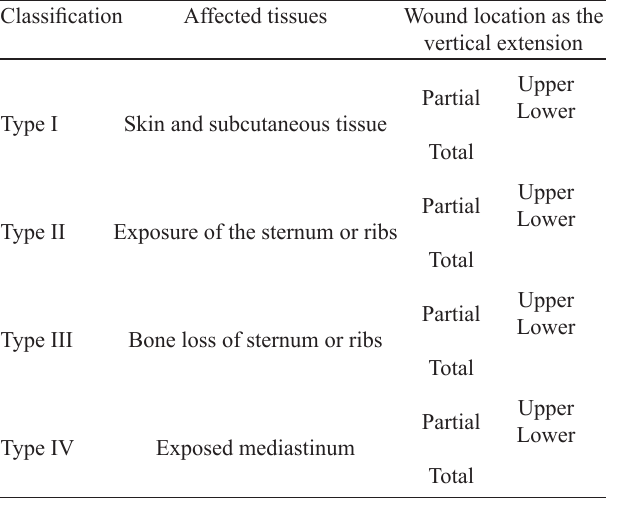
Table 5. Classification proposed by the authors based on anatomical changes, considering the depth and location of the surgical wound. The limit that defines upper and lower region is the inclusion of the lower margin of the pectoralis major